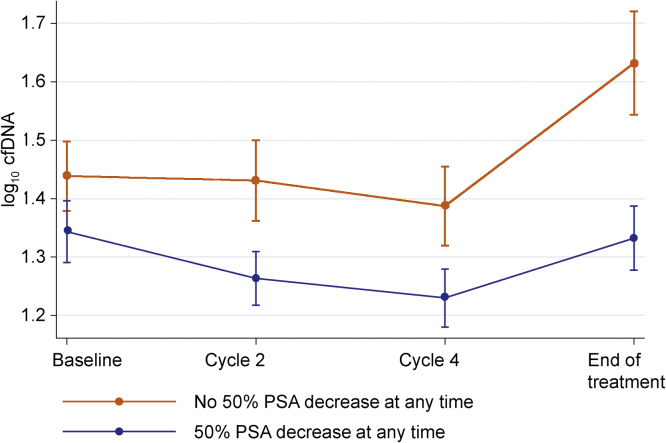
Mean log10 cfDNA concentrations and 95% confidence intervals per cycle by PSA response (decrease of 50% at any time). cfDNA = cell-free DNA; PSA = prostate-specific antigen.